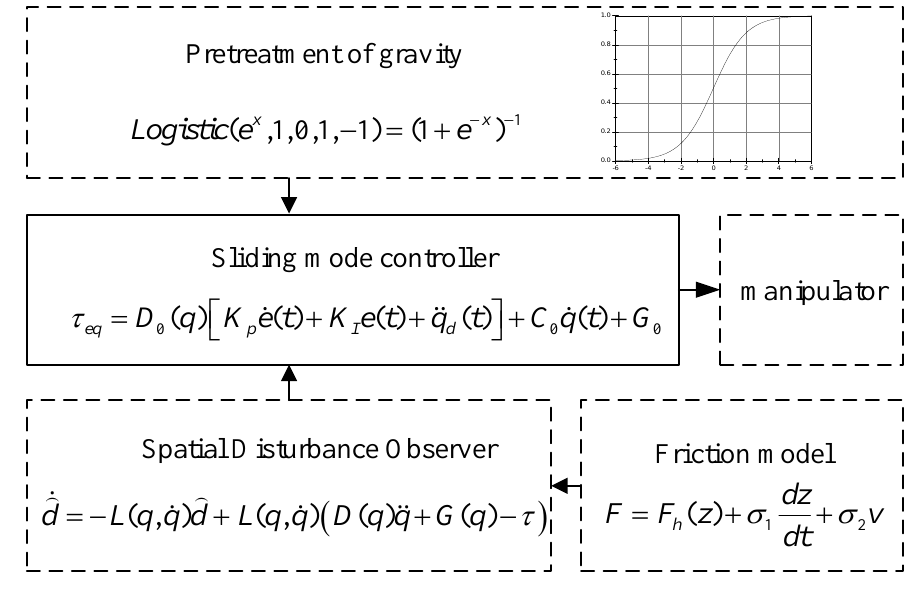
Figure 3. whole block